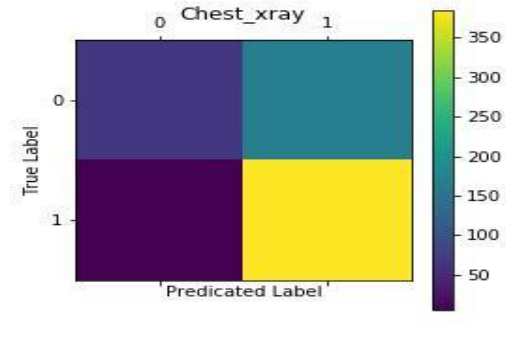
Figure 7. Confusion Matrix for the model